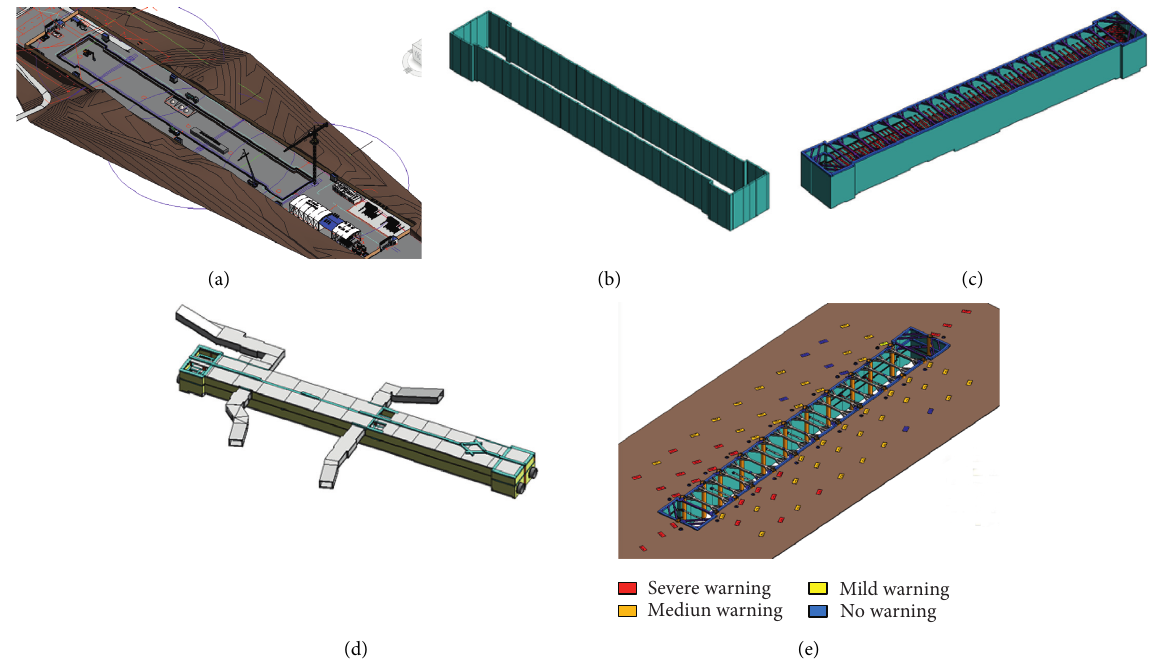
Figure 7: Three-dimensional display of real-time early warning of Xiangjiang New Town Station. (a) Temporary engineering. (b) Enclosure structure. (c) Excavation and support of foundation pit. (d) Main structure of station. (e) Display of monitoring points.